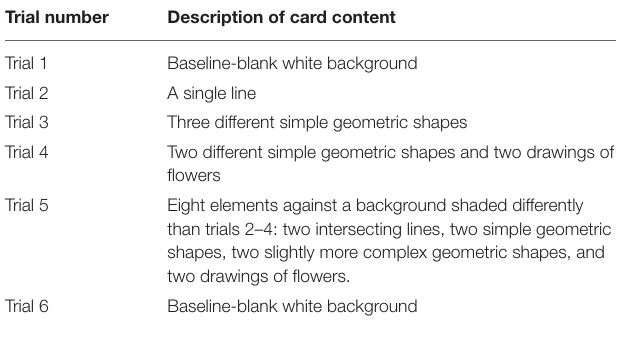
Two different simple geometric shapes and two drawings of flowers Trial 5 Eight elements against a background shaded differently than trials 2–4: two intersecting lines, two simple geometric shapes, two slightly more complex geometric shapes, and two drawings of